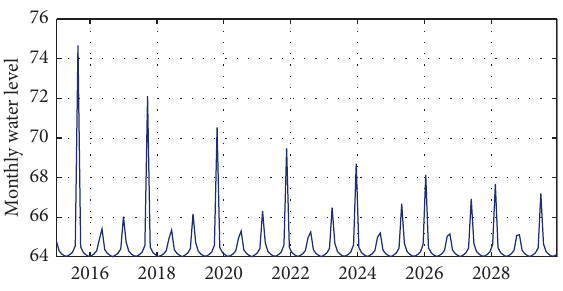
Figure 13: Simulation results of monthly water level in the Biliu Reservoir (2005 ∼